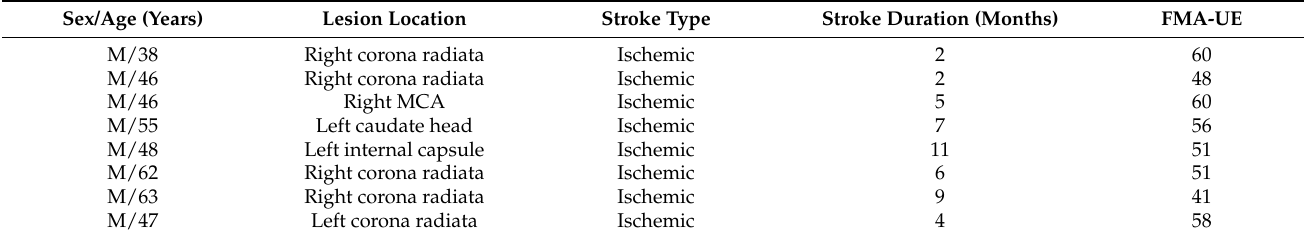
Table 1. Clinical characteristics of the stroke